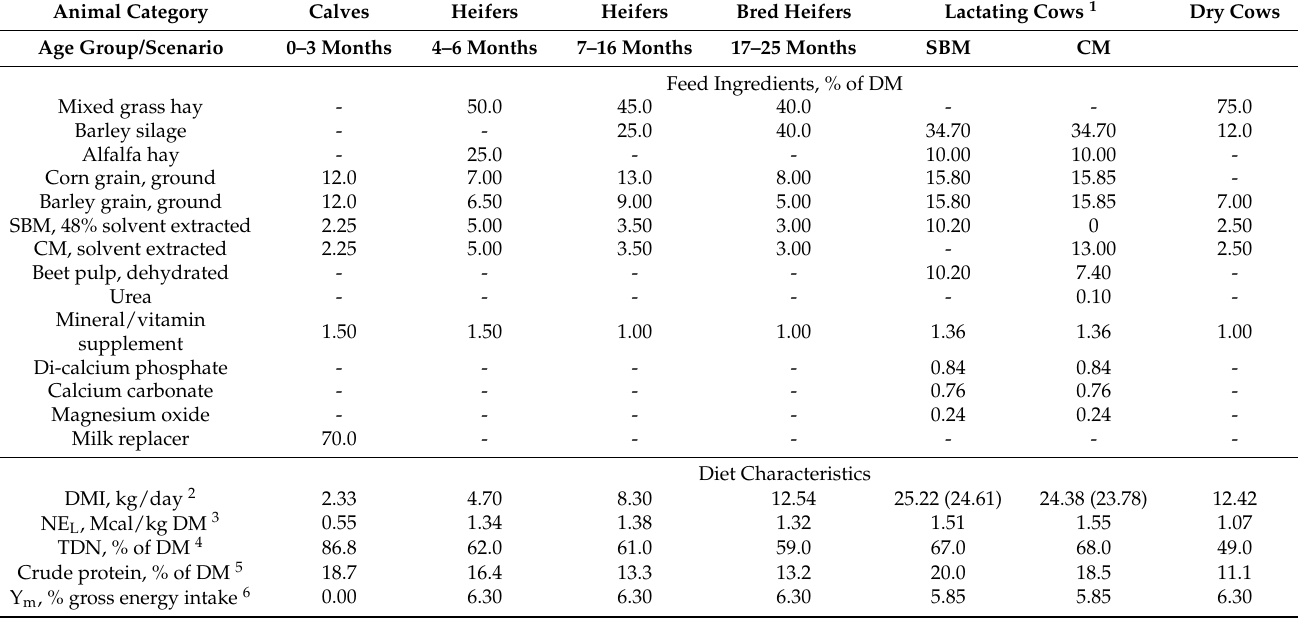
Table 5. Diet ingredients for each animal category for the simulated Alberta dairy farm. Animal